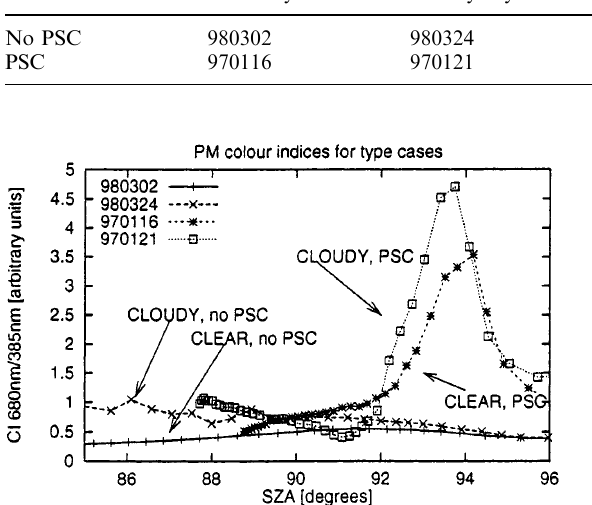
Fig. 1. Colour index development during twilight in the four type cases of Table